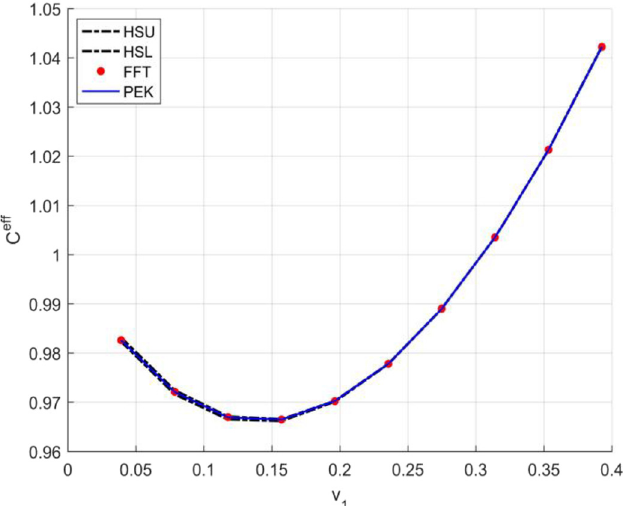
Fig. 6. Effective conductivity of square model with imperfect interface of ellipse Kapitza ’ s type, a =0.2, c 1 = c